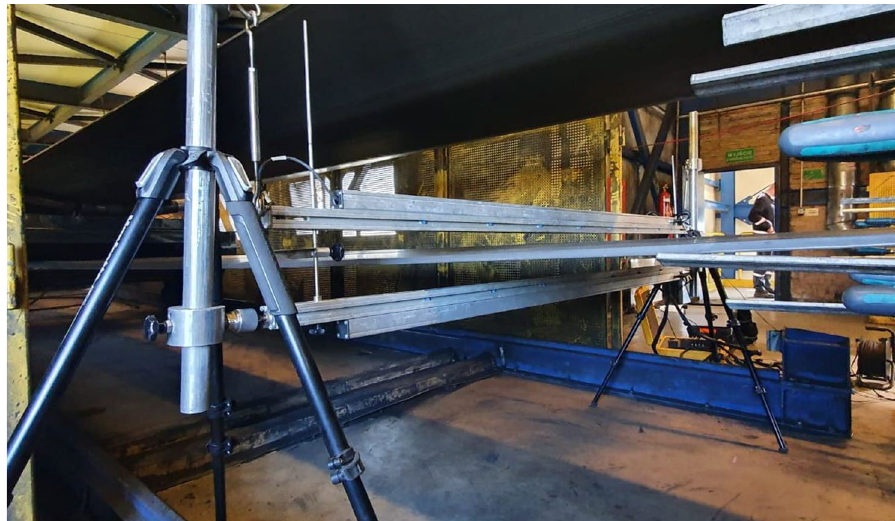
Figure 4. The prototype installed on a conveyor belt in the mine during measurements.